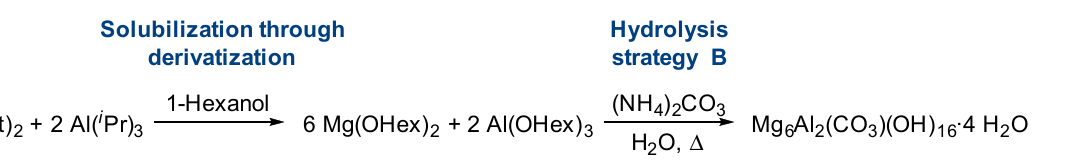
Figure 6. Simplified synthesis of HTCs using an aqueous (NH 4 ) 2 CO 3 solution for the hydrolysis process (Strategy B).